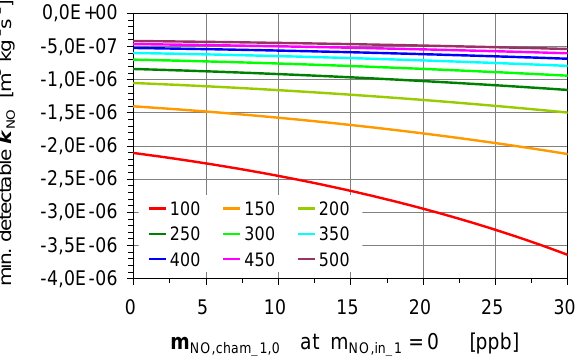
Figure 18. Minimum detectable Q 10 value of NO consumption rate U NO as function of the NO mixing ratio in the soil cham- Fig. 18: Minimum detectable Q 10 -value of NO consumption rate U NO as function of the ber’s headspace ( θ g = θ 0 ; m NO , in_1 / 3 = 0). Data have been cal- NO mixing ratio in the soil chamber’s headspace (  g =  0 ; m NO,in_1/3 = 0). Data culated for m soil , dry = 0.06kg and LOD NO = 0.15ppb, T 0 = 20 ◦ C, have been calculated for m soil,dry = 0.06 kg and LOD NO =0.15 ppb, T 0 =20°C, and and T 1 = 30 ◦ C on the basis of the NO x analyser’s precision (see T 1 =30°C on the basis of the NO x -analyzer’s precision (s. Fig. 8). Color code Fig. 8). Colour code indicates different NO compensation point indicates different NO compensation point mixing ratios, m NO,comp . mixing ratios, m NO , comp